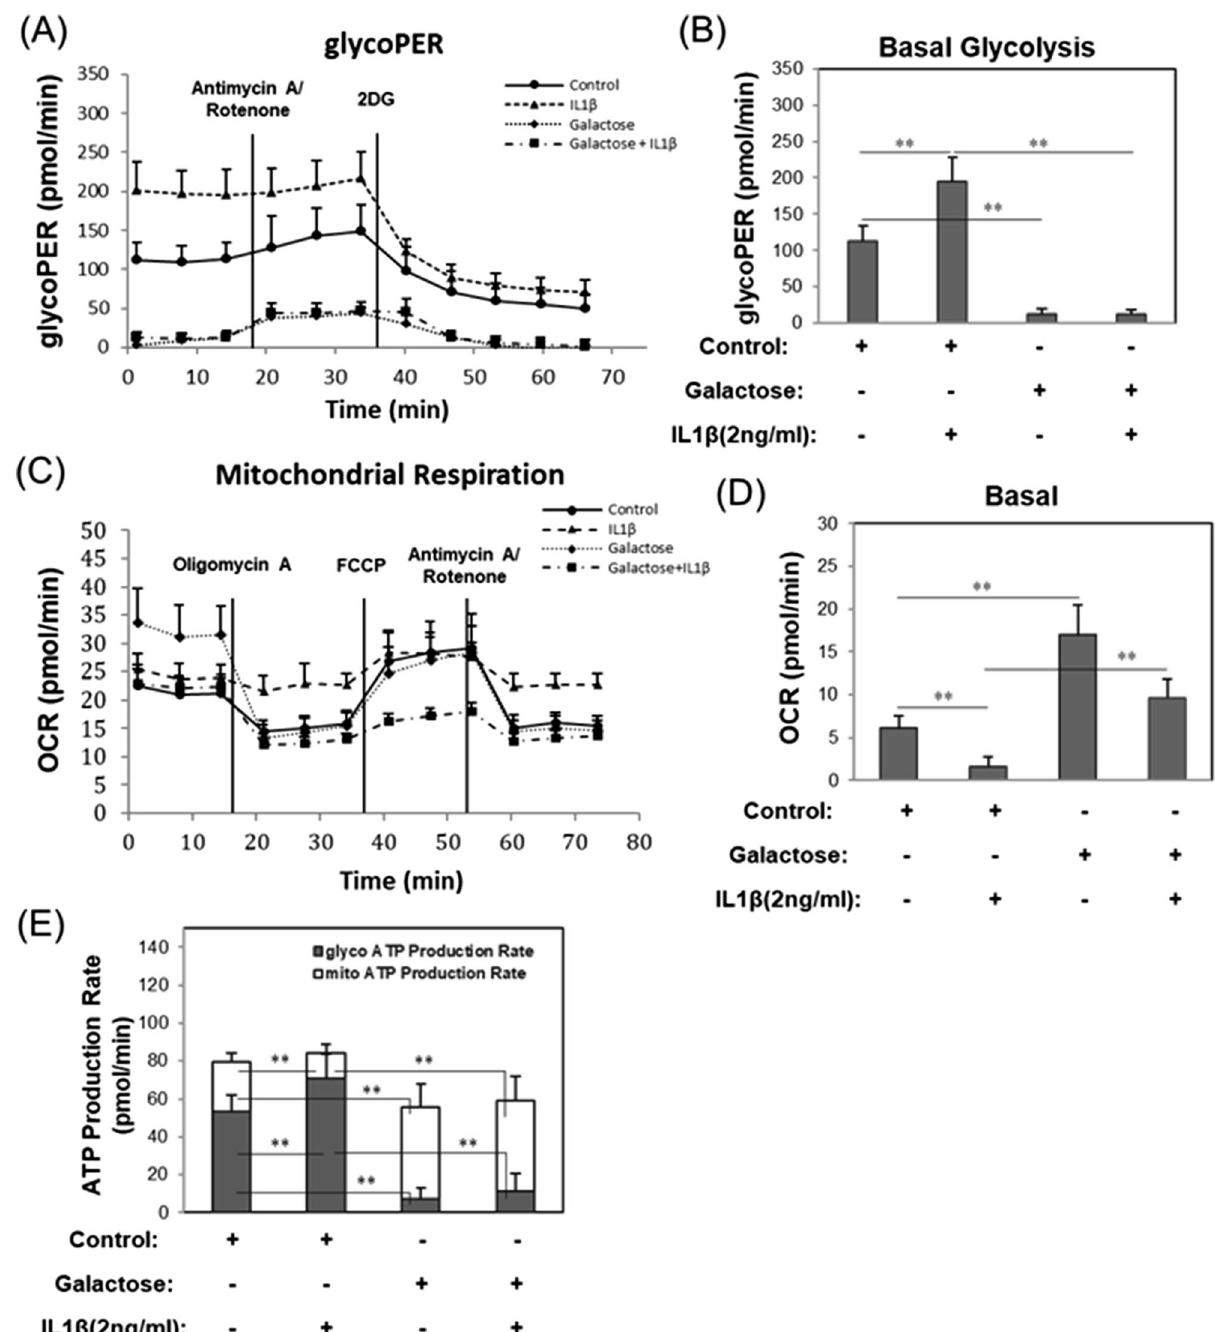
Figure 1. Galactose suppresses glycolysis and enhances mitochondrial respiration. ( A ) Representative Glycolytic Rate Assay kinetic plot wherein values for proton efflux rate (PER, pmol/min) are plotted versus time. Note that rotenone and antimycin A were injected at 18 min followed by high dose 2DG injection at 36 min. ( B ) Summaries of PER data representative of changes in basal glycolysis rates as labeled [mean ± S.D. (error bars), n = 10]. ( C ) Representative Mito Stress Test kinetic plot wherein values for Oxygen Consumption Rate (OCR, pmol/min) are plotted versus time. Note that oligomycin A was injected at 18 min followed by FCCP injection at 36 min. rotenone and antimycin A were injected at 54 min. ( D ) Summaries of OCR data representative of changes in basal mitochondrial respiration as labeled [mean ± S.D. (error bars), n = 8]. ( E ) Representative Real- Time ATP Production Rate Assay in bovine chondrocytes wherein the contribution of glycolysis (gray bars) and mitochondrial respiration (open bars) to ATP production after treatments for 24 h are as labeled [mean ± S.D. (error bars), n = 10]. ANOVA followed by Tukey post-hoc test was used for statistical analysis. *p < 0.05; **p <